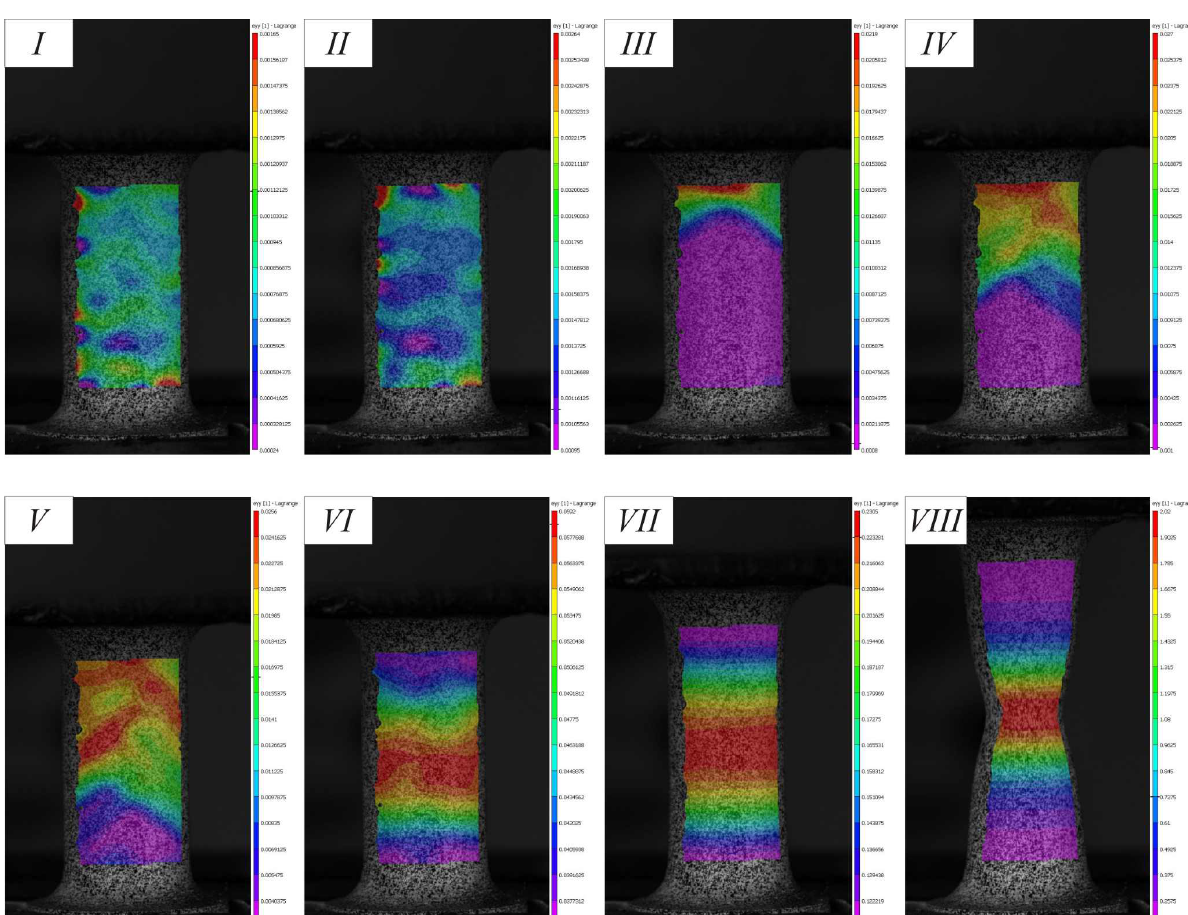
Figure 3: Evolution of axial strain fields during uniaxial tension of cylindrical